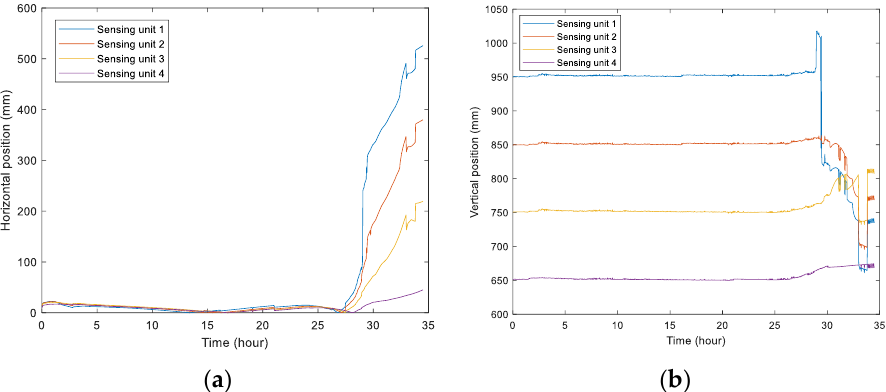
Figure 13. The curve of original displacement data. ( a ) Graph of original horizontal displacement versus time. ( b ) Graph of original vertical displacement versus time.